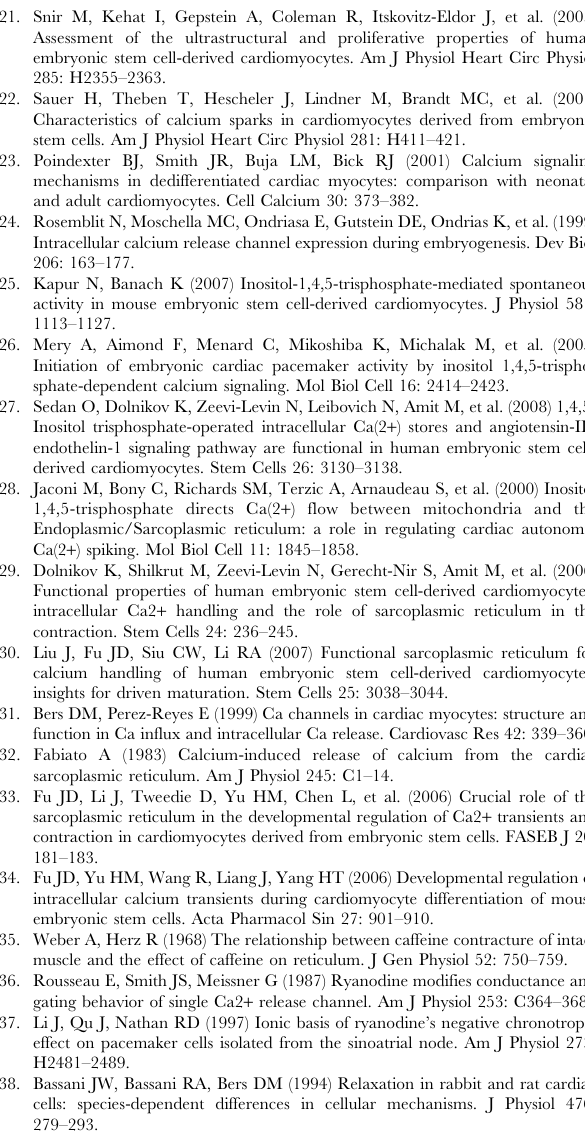
clone 1 (left), hIH1 clone 2 (middle) and hfib2-5 (right). ( B ) Line- scan tracings of whole-cell [Ca 2 + ] i transients recorded from hIH1 clone 1 (top), hIH1 clone 2 (middle) and hfib2-5 (bottom) under baseline conditions (left) and in the presence of 10 m M Ryanodine (right). ( C ) Dose-response curve for ryanodine (5, 10, and 20 m M) displayed as the percent decrease in [Ca 2 + ] i transients amplitude from baseline values (n =5, **p , 0.01 when mean absolute values were compared to baseline values). Abbreviations: F/Fo, fluores- cence (F) normalized to baseline fluorescence (Fo); sec, seconds. Figure S3 The effects of SERCA inhibition in cardiomy- ocytes derived from the hfib2-5 line. ( A ) Line-scan tracings of whole-cell [Ca 2 + ] i transients in a representative hfib2-5 hiPSC- CM under baseline conditions (left) and after 30 minutes (right) of constant 10 m M thapsigargin exposure. ( B ) Caffeine-induced Ca 2 + transients (denoted by arrows) under baseline conditions (upper), after 30 minutes (middle), and 32 minutes (lower) of thapsigargin